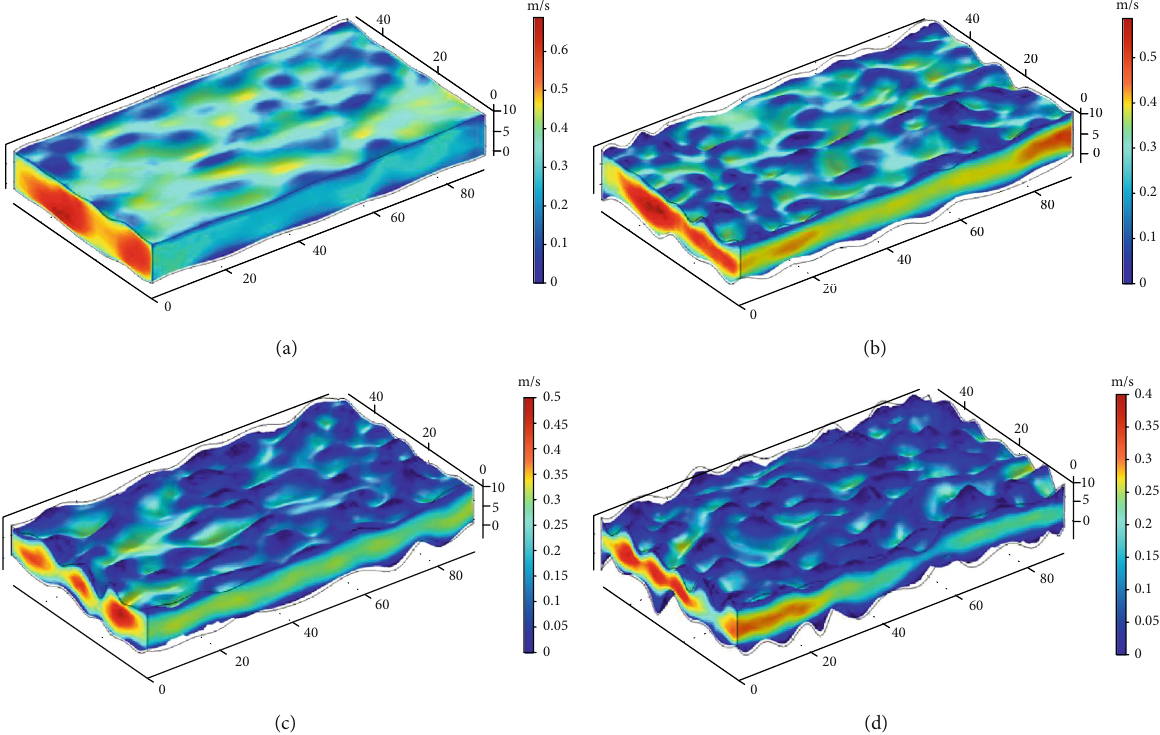
Figure 9: Velocity distribution of the samples with di ff erent JRCs. (a) Sample 1. (b) Sample 2. (c) Sample 3. (d) Sample 4.